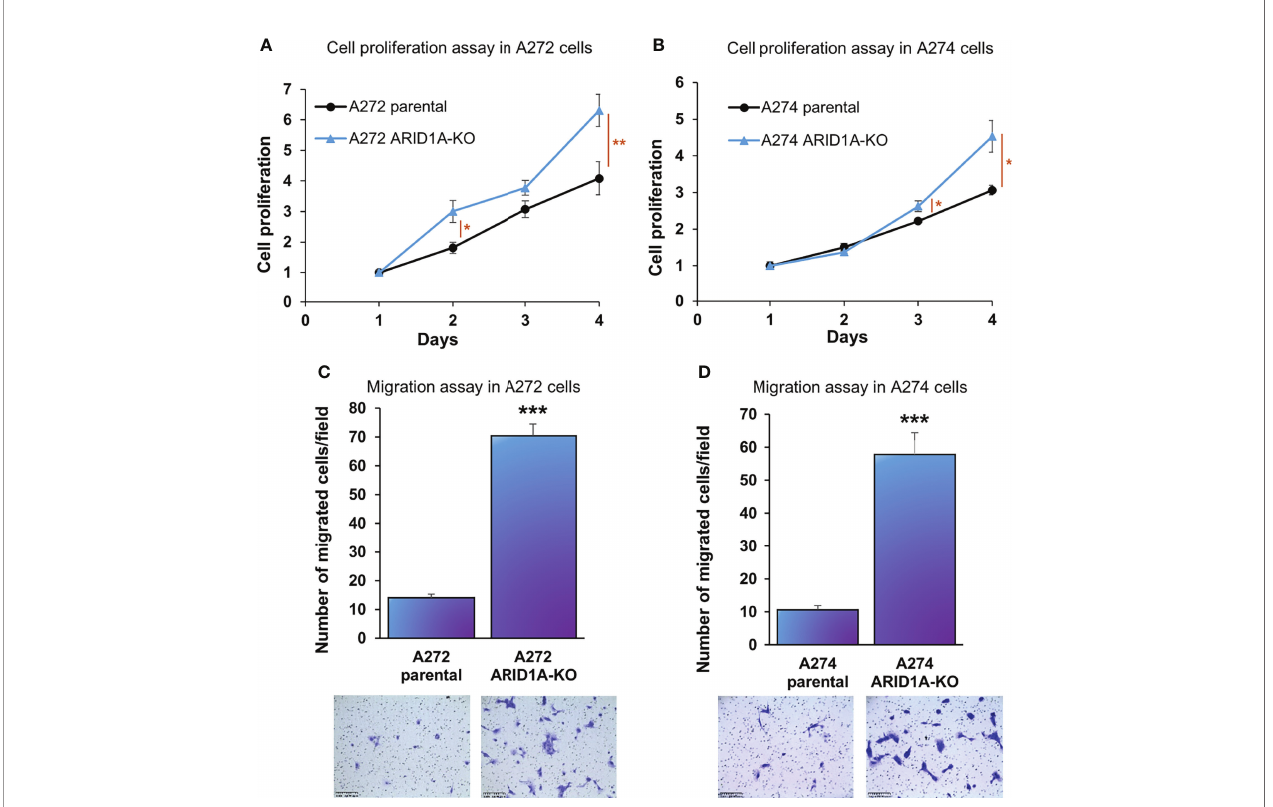
FIGURE 5 | ARID1A knockout increases the proliferation and migration of porcine HCC cells. (A, B) Cell proliferation was determined for A272 (A) and A274 (B) parental and ARID1A KO cells by MTS assay. Cell viability at different time points (days) was measured and expressed as A 490 normalized to values of day 1. Statistical analysis was conducted to compare viability of the different cell lines at each time point by two-way ANOVA. *, p < 0.05; **, p < 0.005. (C, D) Migration of A272 ARID1A KO (C) and A274 ARID1A KO (D) cells in comparison to parental cells was assessed by transwell cell migration assay. Quantitated migration ability is presented as the number of migrated cells per fi eld. Values in the bar graph represent mean ± S.E. (n = 6 fi elds). ***, p < 0.0001. Representative images of migrated cells stained with crystal violet are shown below each bar graph. Scale bar, 250 m